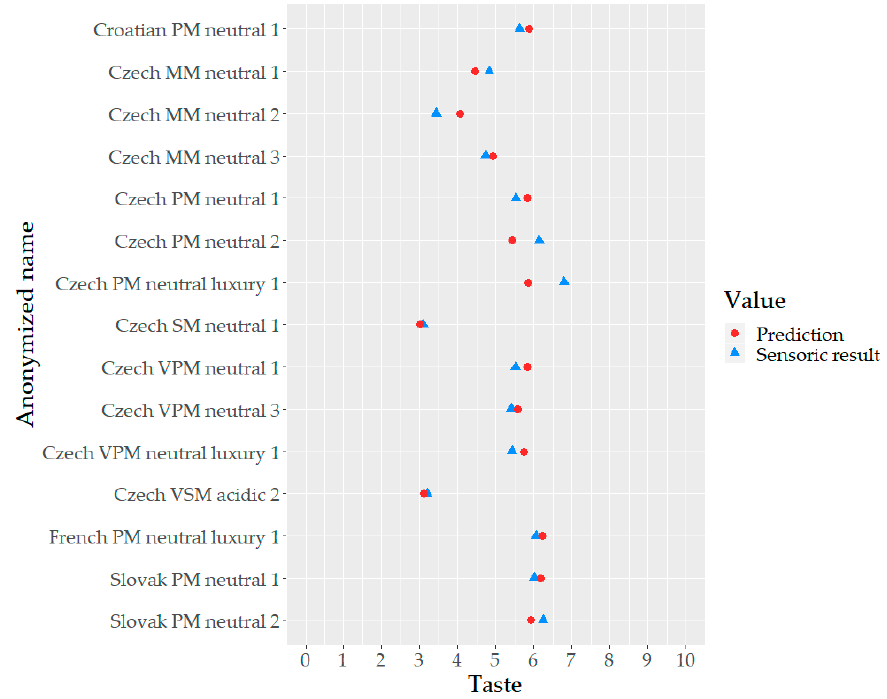
Figure 2. How well the model predicted the actual value of taste. For all but three mineral waters, predicted value based on the estimated model corresponded well with the actual value of taste. Exceptions were Czech MM neutral 2, Czech PM neutral 2, and Czech PM neutral luxury 1. However, even for those three types, the difference was around 15%.